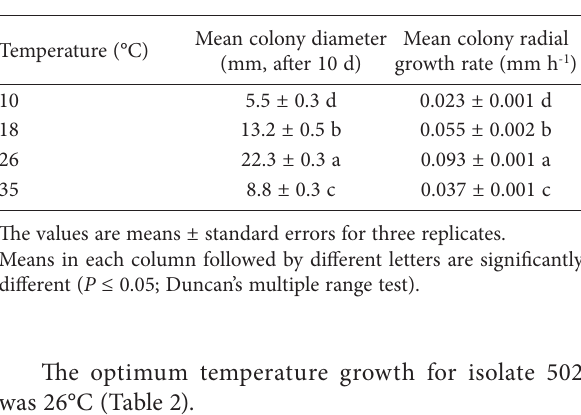
Table 2. Mean Plectosphaerella melonis (isolate 502) colony diam- eters and growth rates at different temperatures.